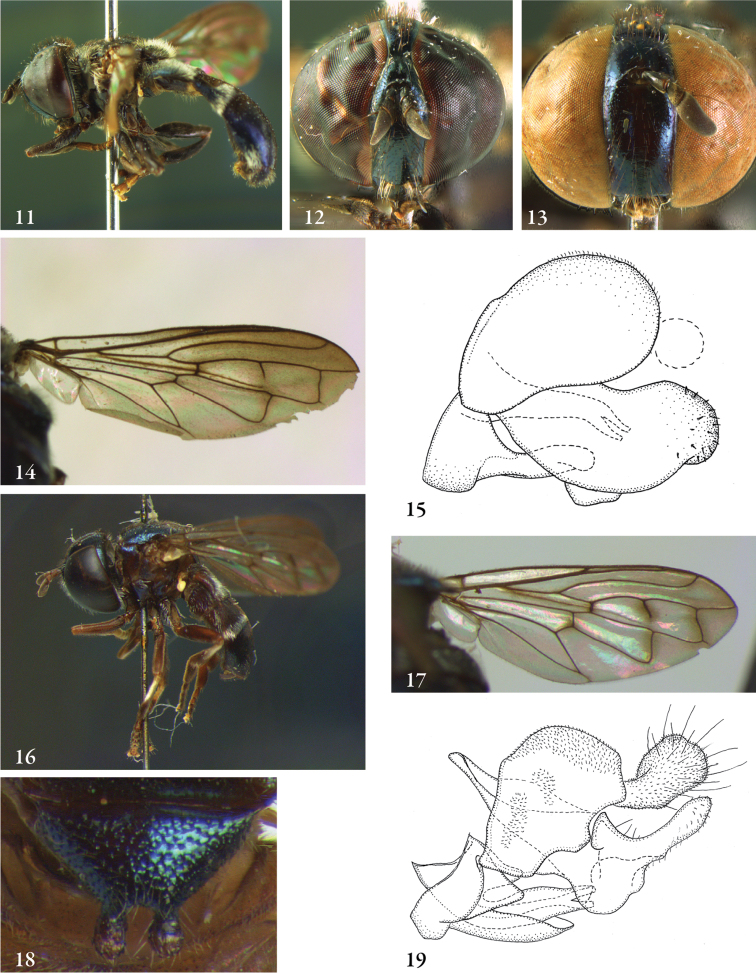
11–15
Archimicrodon (s.s) malukensis: 11 male (holotype), habitus lateral 12 male (holotype), head frontal 13 female (paratype), head frontal 14 male (holotype, wing 15 male (paratype), genitalia lateral 16–17
Archimicrodon (Hovamicrodon) silvester male (holotype): 16 habitus lateral 17 wing 18–19
Archimicrodon (Hovamicrodon): 18
Archimicrodon nubecula female (holotype), scutellum 19
Archimicrodon silvester male (holotype), genitalia lateral.